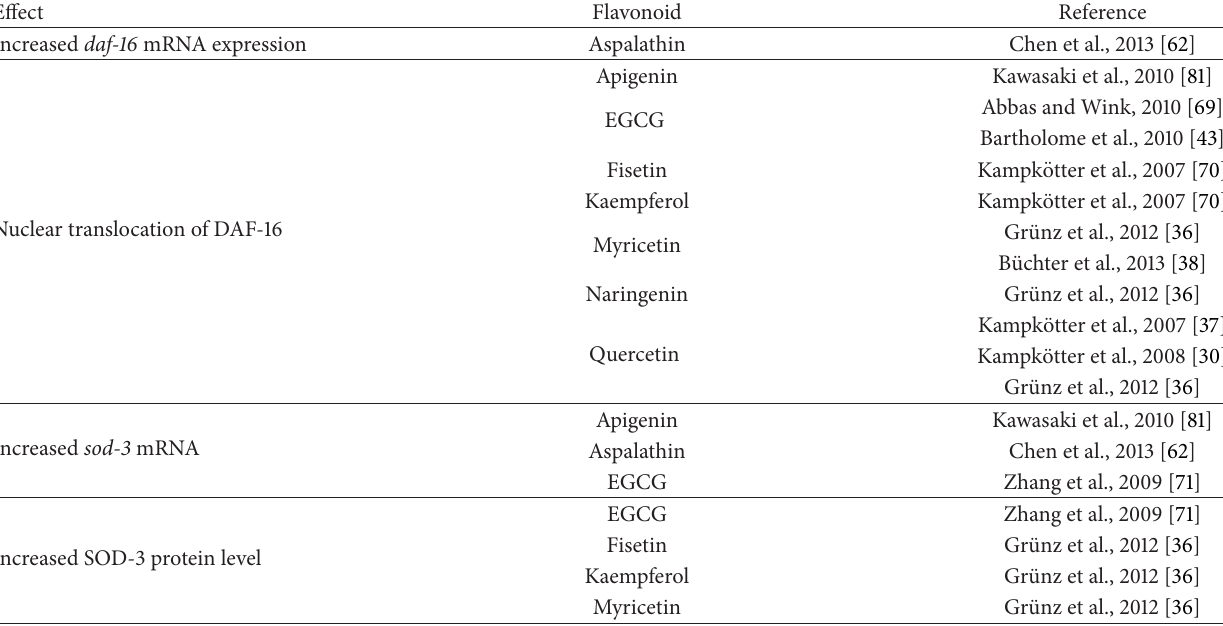
Table 5: Modulation of gene expression and protein localisation of DAF-16 and its target